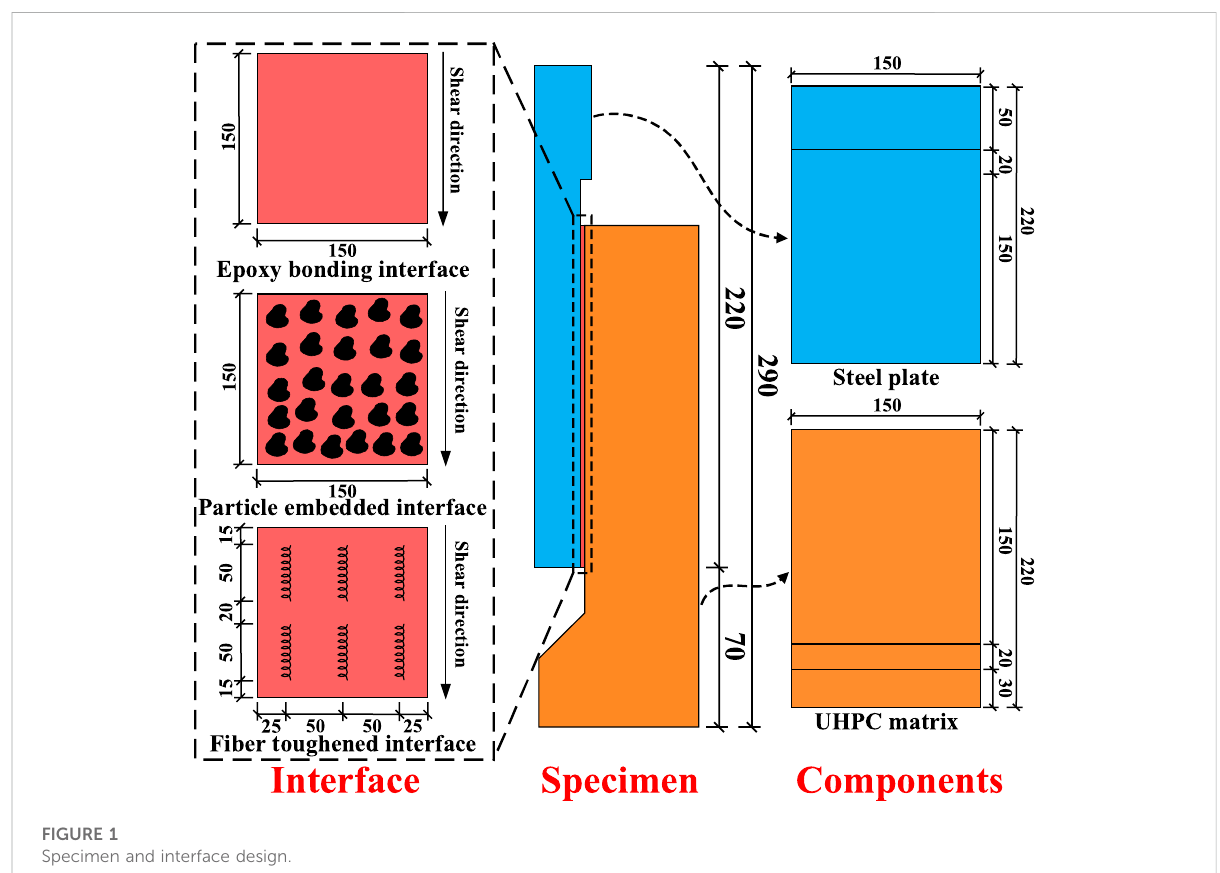
FIGURE 1 Specimen and interface design.